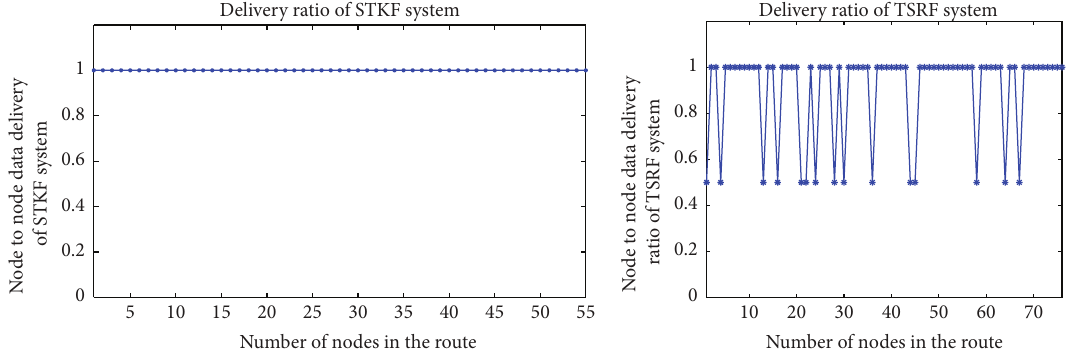
Figure 4: Graph representing comparison of delivery ratio.